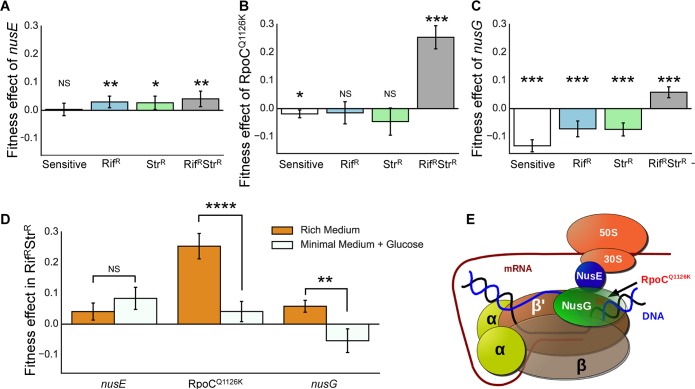
Mutations specifically compensating for epistasis between RifR and StrR.Fitness effect of specific compensatory mutations across backgrounds. Strains were constructed with each compensatory allele and competed against their corresponding ancestral (i.e., the resistant or the sensitive strain without the compensatory mutation). Mean values shown in columns (assays based on four independently constructed clones for each allelic replacement, each with at least n = 3 competitions, * p < 0.05, **p < 0.01, ***p < 0.001 from a one sample t-test), error bars indicate twice the Standard Error of the Mean (2SEM). (A) nusE is beneficial in all resistance backgrounds and neutral in the sensitive background (s = 0.04 ± 0.03 [2SEM], p = 0.01 for RifR StrR background; s = 0.03 ± 0.02 [2SEM], p = 0.037 for StrR background; s = 0.03 ± 0.02 [2SEM], p = 0.008 for RifR background; s = 0.003 ± 0.002 [2SEM], p = 0.774 for sensitive background, one-sample t-test). (B) RpoCQ1126K shows a strong benefit in the double-resistance background (0.25 ± 0.04 [2SEM], p < 0.0001), whilst being neutral in RifR (s = −0.02 ± 0.04 [2SEM], p = 0.457) and deleterious in both the StrR and the sensitive backgrounds (s = −0.05 ± 0.05 [2SEM], p = 0.085 or (s = −0.02 ± 0.01 [2SEM], p = 0.015) for the RpsLK43T or the sensitive, respectively). (C) nusG is beneficial in the double-resistance background (s = 0.06 ± 0.02 [2SEM], p < 0.0001) and deleterious in all other backgrounds (s = −0.07 ± 0.02 [2SEM], p < 0.0001 for StrR background; s = −0.07 ± 0.03 [2SEM], p < 0.0001 for RifR background; and s = −0.132 ± 0.02 [2SEM], p < 0.0001 for sensitive background). (D) The benefit of RpoCQ1126K mutation is significantly reduced and nusG is deleterious in minimal media supplemented with glucose (M9+Glucose), where the epistasis between RifR and StrR does not take place. However, nusE, which does not seem to specifically compensate for the epistasis, is beneficial regardless of the media. (E) Schematic representation of the coupling between the RNA polymerase (RNAP) and the ribosome mediated by the NusE–NusG complex. A red cross represents the approximate position of RpoCQ1126K in the domain of RpoB that NusG binds to.